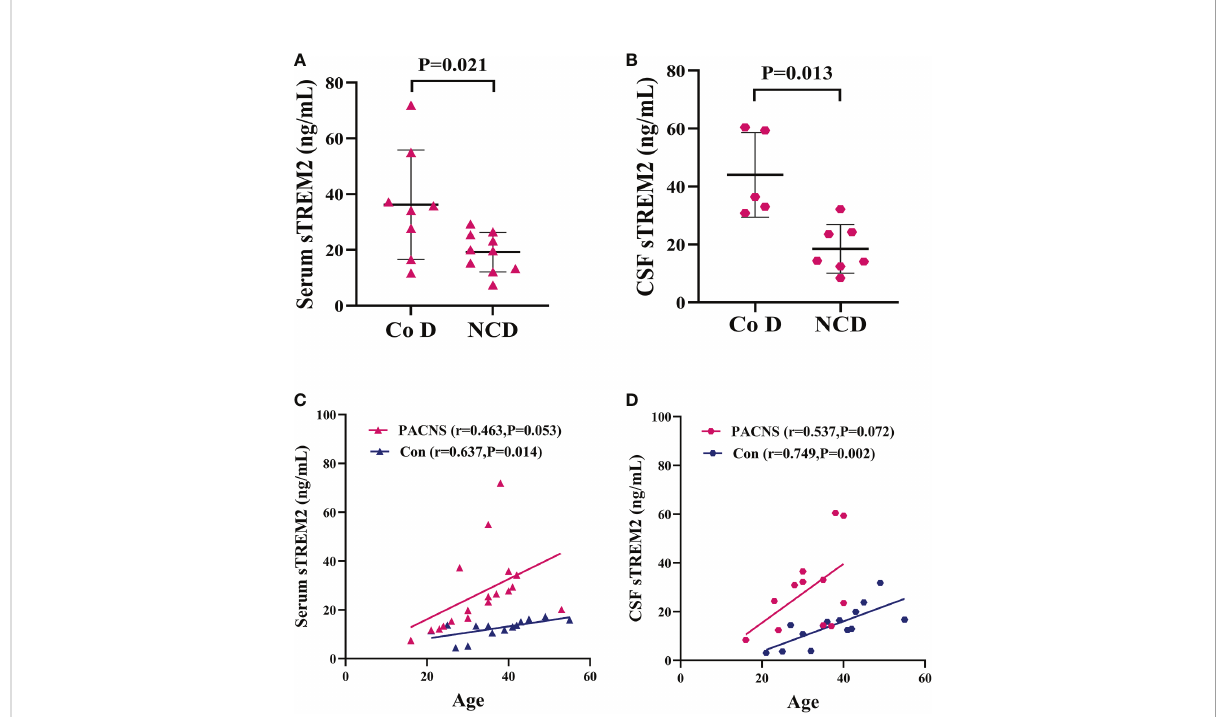
FIGURE 7 Elevated serum and CSF sTREM2 concentrations in PACNS patients were associated with cognitive dysfunction and patient age. Co D, cognitive dysfunction. NCD, non cognitive dysfunction. (A, B) In the serum (n=18) and CSF (n=12) samples, sTREM2 concentrations were higher in PACNS patients with cognitive dysfunction that in those without. (C) In the serum samples, the sTREM2 concentration in PACNS (n=18) was correlated with patient age, whereas the sTREM2 concentrations in control (n=14) were signi fi cantly related to age. (D) In CSF samples, this correlation in PACNS group (n=13) approached signi fi cance, and the CSF sTREM2 concentration in control group (n=14) showed a strong correlation with